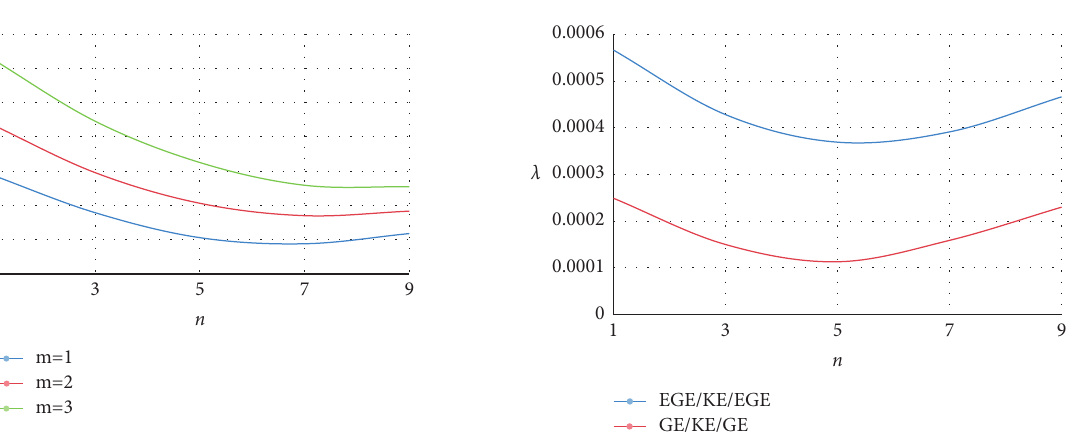
Figure 10: Relation between frequency and circumferential node number of three-layered shells 0 0 /90 0 /0 0 L � 1 .